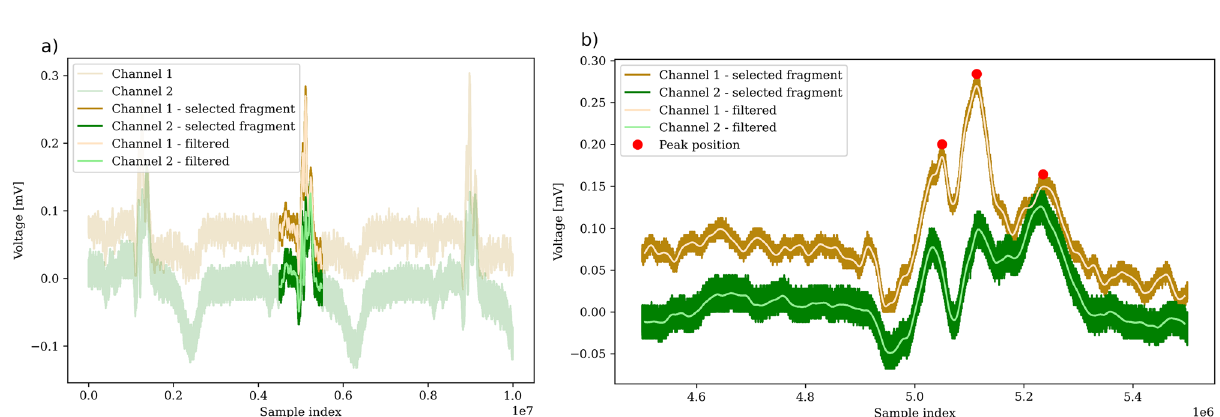
Figure 2. Example of the signal obtained for Subject #1. Figure ( a ) presents the wider scope of three cycles of ECG signal, Figure ( b ) presents the enlarged view of the particular QRS complex. Channel 1 is represented by a dark yellow color, Channel 2 is represented by a dark green color. Light yellow and light green represents signal filtered with a rolling mean filter with a rectangular window of size 5001 samples. Since the signal is obtained with an equipment of a sampling frequency approximately 1000 times higher than in standard ECG measurement, higher amplitude and frequency of noise is observed. However, the signal to noise ratio which equals 12.45 dB is satisfactory, as it allows to reliably determine the QRS complex position and cross-correlation can be computed. With lower sampling frequency signal to noise ratio increases (as can be seen in the ( a ) and ( b ), light yellow and light green color represents filtered signal).